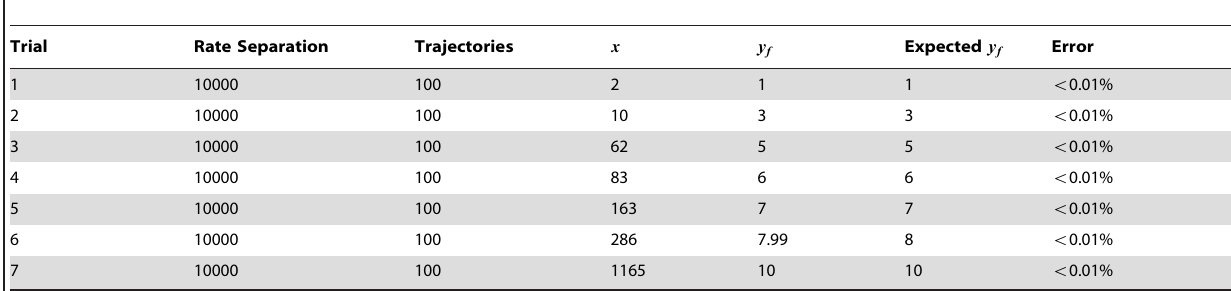
Table 6. Statistical Simulation Results from ‘‘Logarithm’’ Construct.